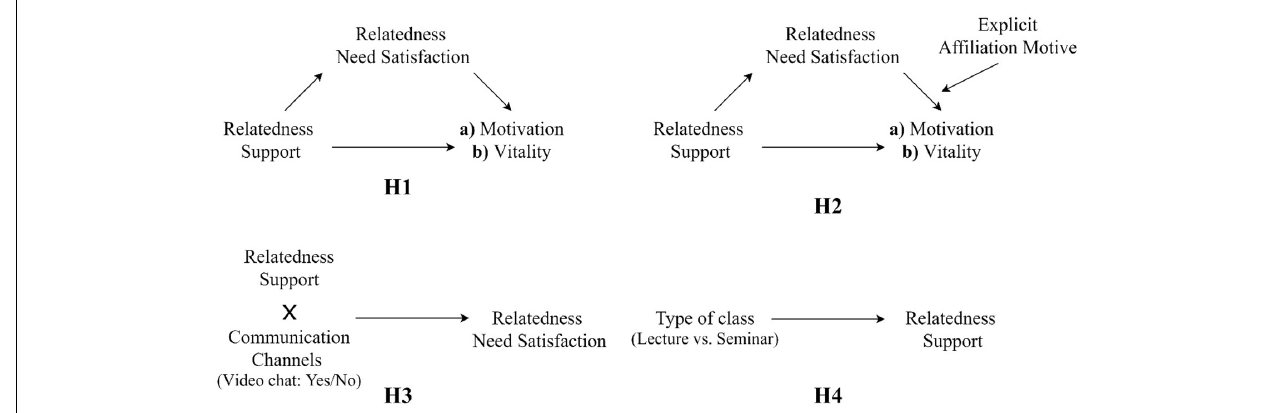
FIGURE 1 | Conceptual models for the tested hypotheses (H1a, H1b, H2a, H2b, H3, and H4). For H1 and H2, motivation and vitality are assessed in separate